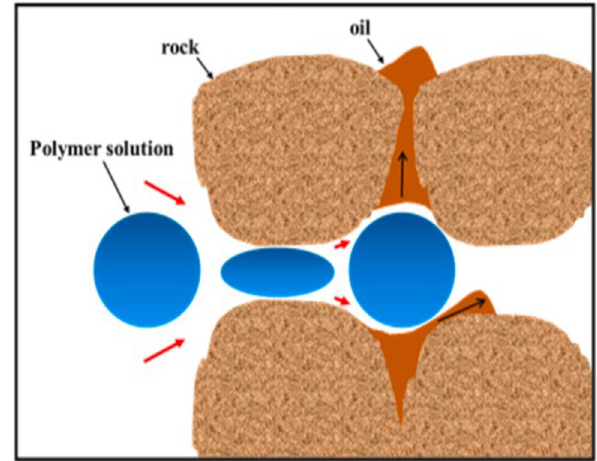
Figure 7: Viscoelastic polymer fl ooding mechanism [ 119 ]